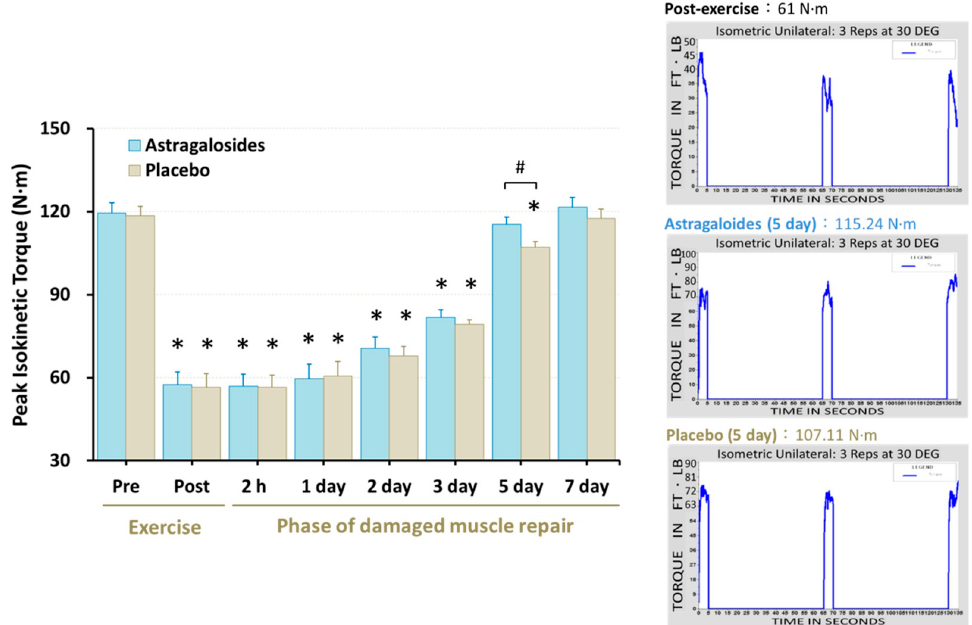
Figure 5. Effect of astragalosides supplementation on muscular force recovery after muscle dam- age. Peak isokinetic torque was measured before and after eccentric exercise, and at 2 h, 1, 2, 3, 5, and 7 days of the recovery period. Values are expressed as means ± SD ( n =11). * p < 0.05 vs. pre-exercise for the same group. # p < 0.05 vs. placebo for the same time. The right panel shows representative peak isokinetic